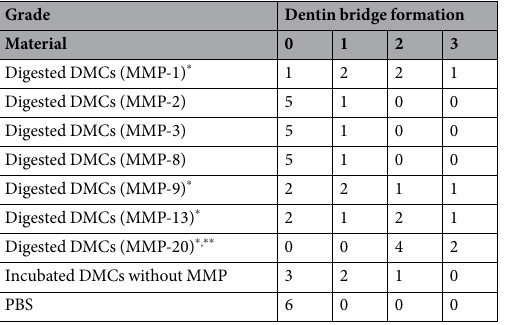
Table 2. Grading results of the dentin bridge formation following the criteria of pulp histological consecutive sections 4 weeks after direct pulp capping (n = 6 per group). * 1 µ g/ml of DMCs treated with MMP-1,